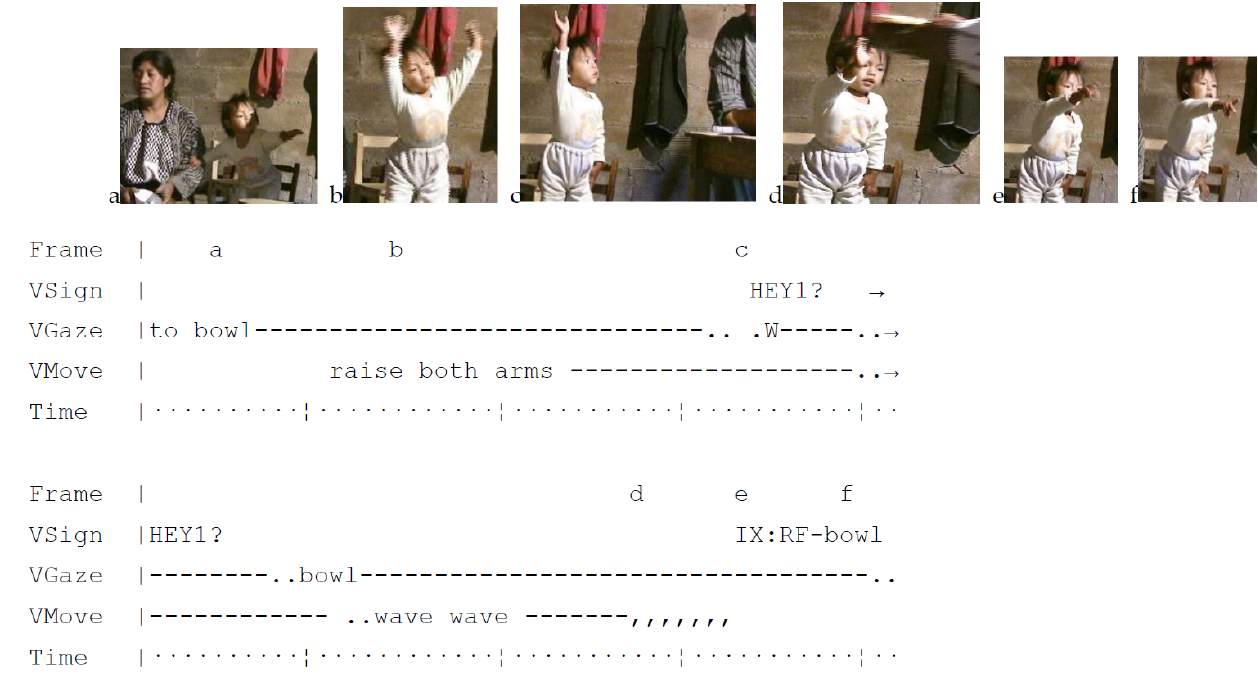
Figure 16. At 18 mos., Vic engages and tried to manipulate attention with deaf adults.